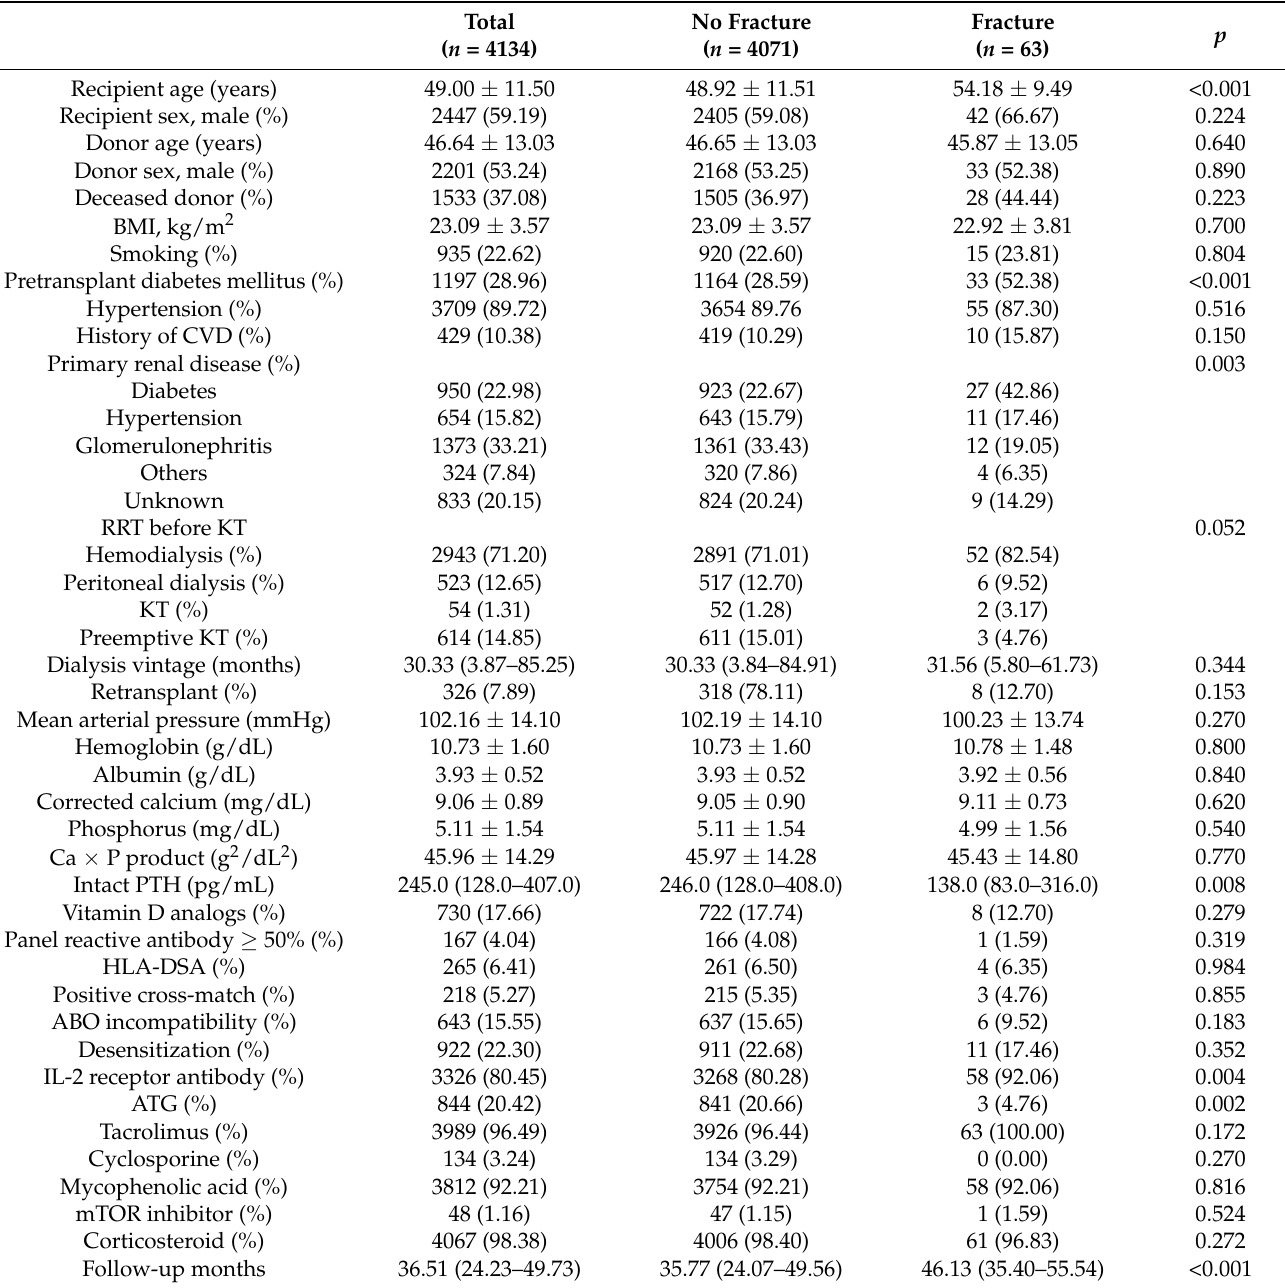
Table 1. Baseline characteristics of the kidney transplant